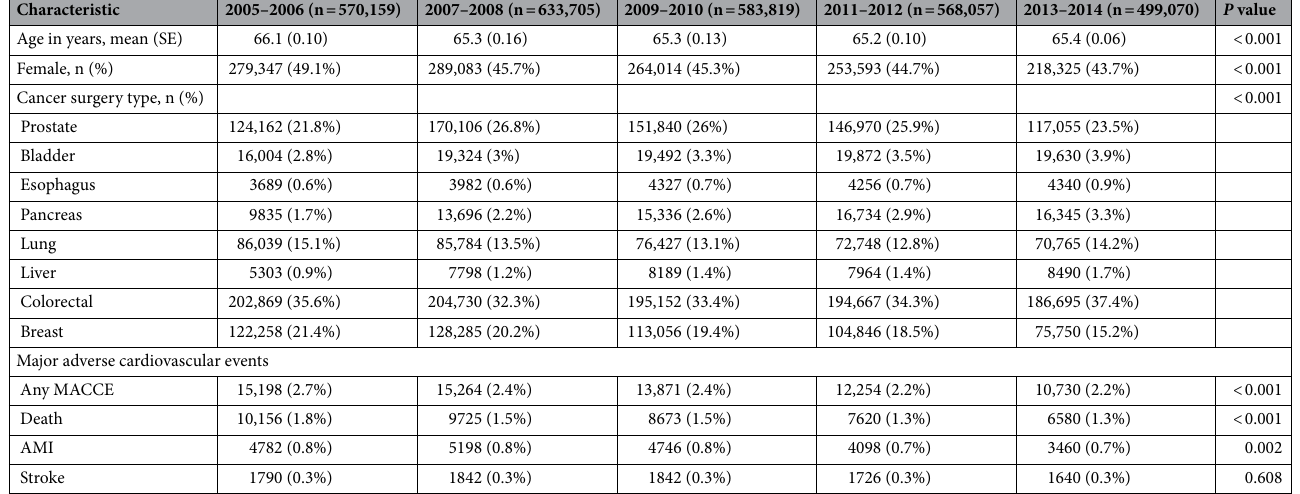
Table 2. Trends in cardiovascular outcomes of major cancer surgery over time. AMI acute myocardial infarction, MACCE major adverse cardiovascular and cerebrovascular